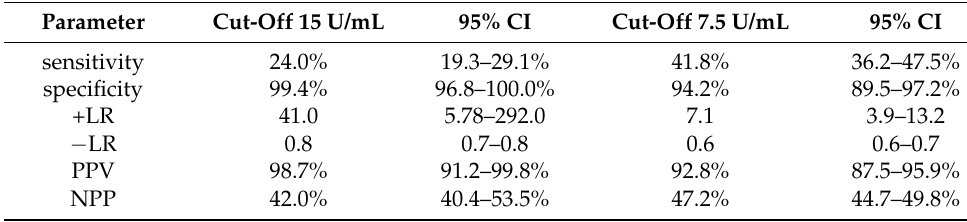
Table 2. Assay performance analysis of PR3-ANCA measurements by the third-generation ELISA using the recommended cut-off of 15 U/mL and a lowered cut-off of 7.5 U/mL. Abbreviations: confidential interval, CI; negative predictive value, NPV; positive predictive value, PPV; positive likelihood ratio, +LR; negative likelihood ratio, −